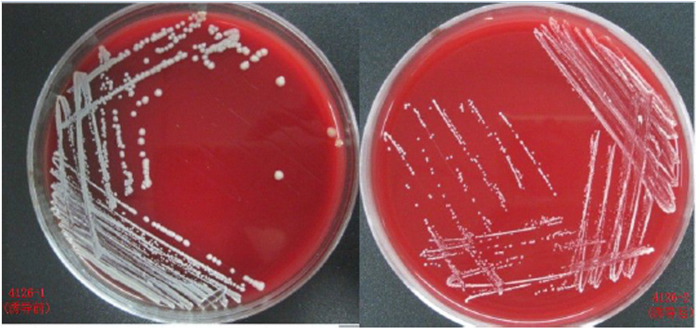
VISA colony morphology.